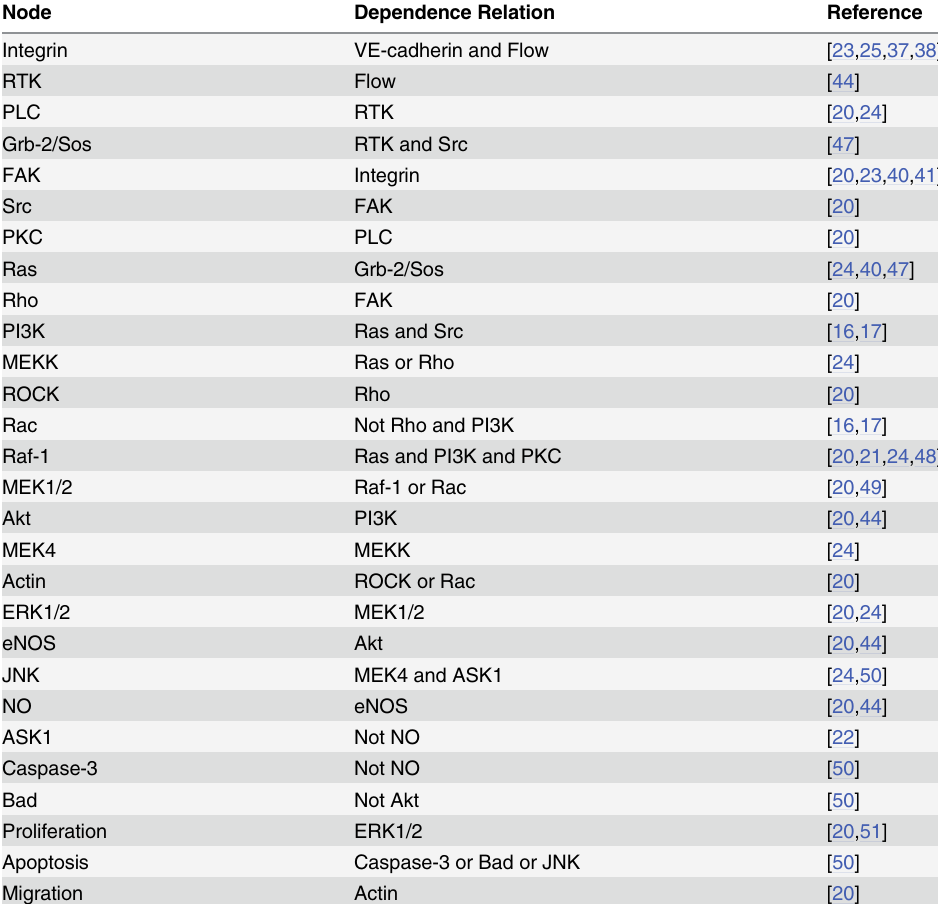
Table 1. Nodes dependence relation and corresponding reference for shear stress signaling